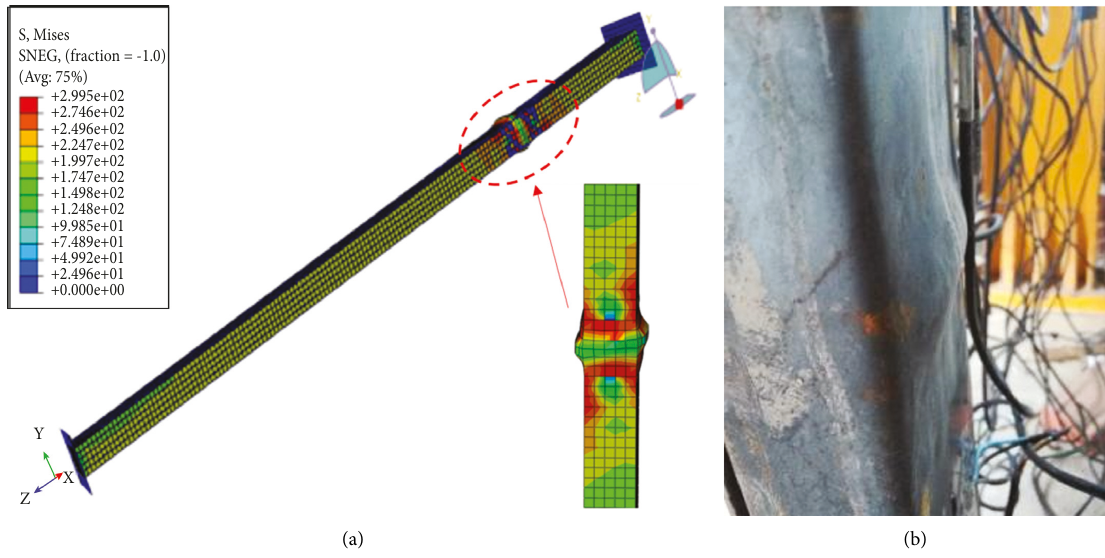
Figure 15: Result comparison of FEM and test for the specimen Z120-2.2-20. (a) FEM result. (b) Test